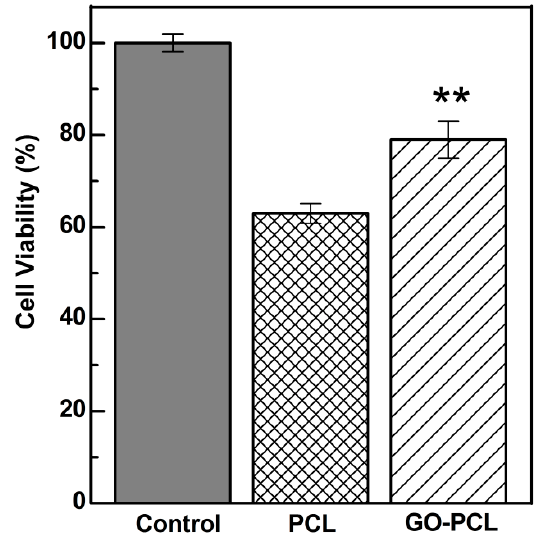
Figure 5. MTS assay after 24 h of incubation of the scaffolds with HDFa. Cell adhesion values are calculated comparing cell viability on each scaffold to that obtained for the free well (positive control). Data shown as mean ± s.e.m. (n = 6, two independent biological replicates); **P < 0.01 (Siegel–Tukey test).